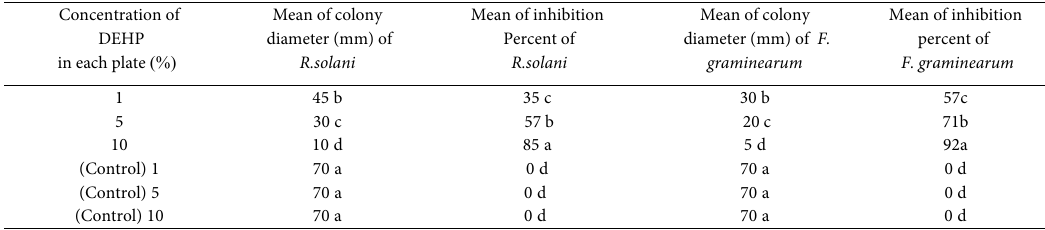
Fig. 2. UV-Visible Absorption Spectra of Di-Butyl Phthalate (1) and Di-(2-Ethyl hexyl) Phthalate (2) [17] Table 1. Effect of different concentrations of DEHP on R.solani and F. graminearum , 96 hours after culturing. (Numbers followed by the same letter are not significantly different (P<0.01)